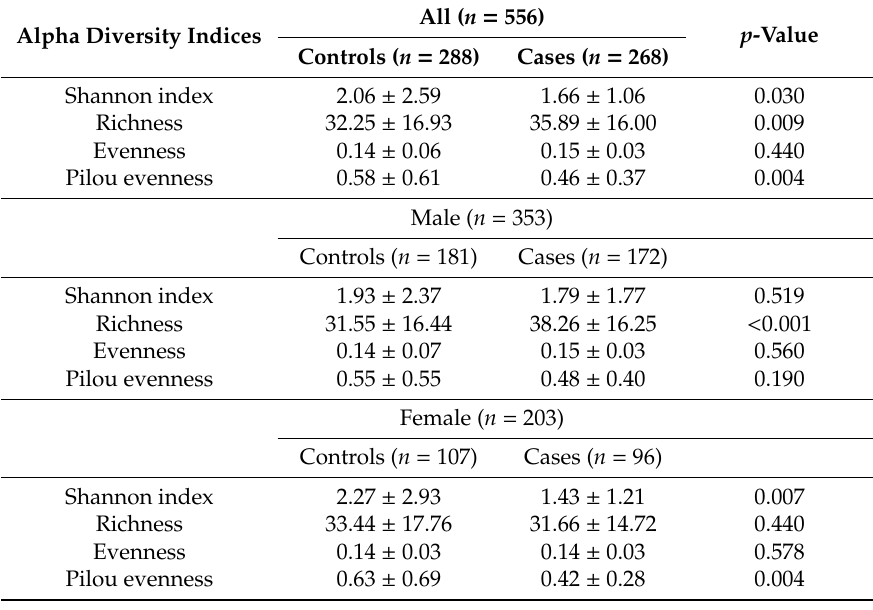
Table 1. Comparison of diversity measures between gastric cancer (GC) cases and